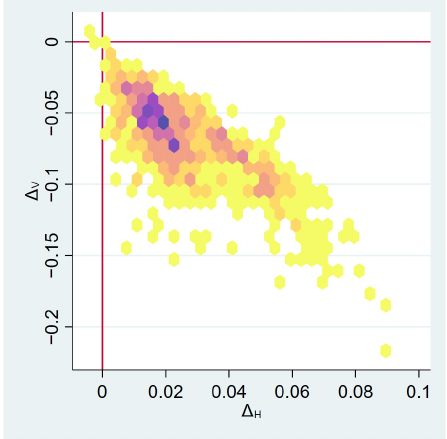
Figure 1. Differences in coefficients derived from 1000 bootstrap samples. Table 3 outlines the predictions and the average partial effects derived from Model